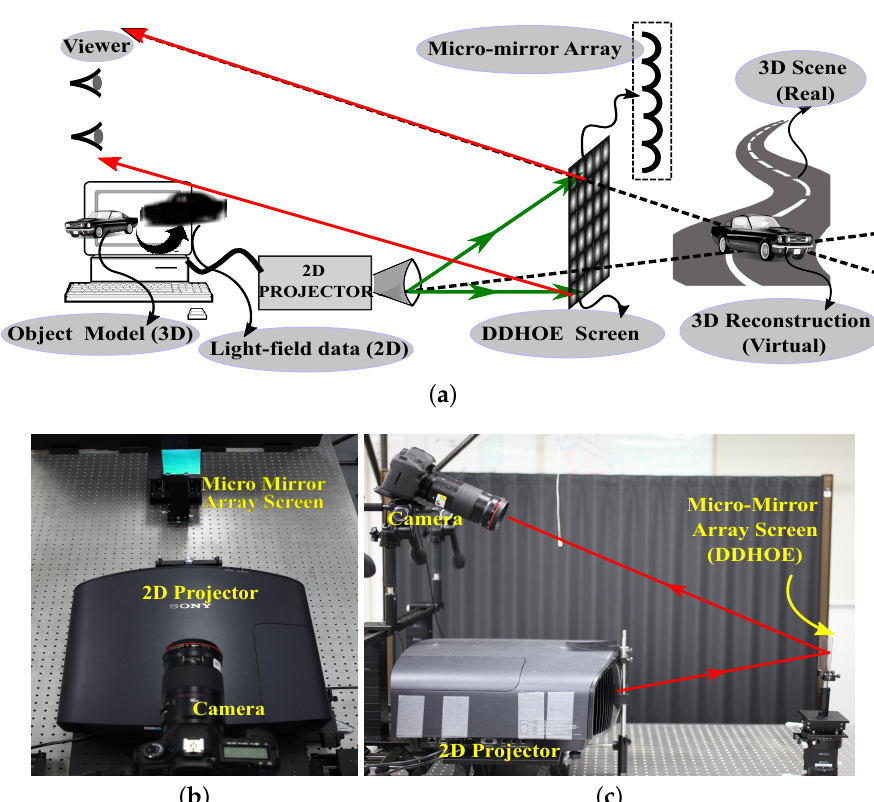
Figure 1. ( a ) schematic of the light-field display system; ( b ) photograph of the top-view of the real display system; ( c ) photograph of the side view of the real display system.